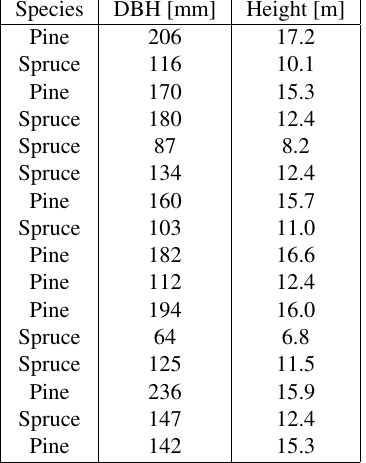
Table 1. Stem diameter at breast height and tree height for the field trees